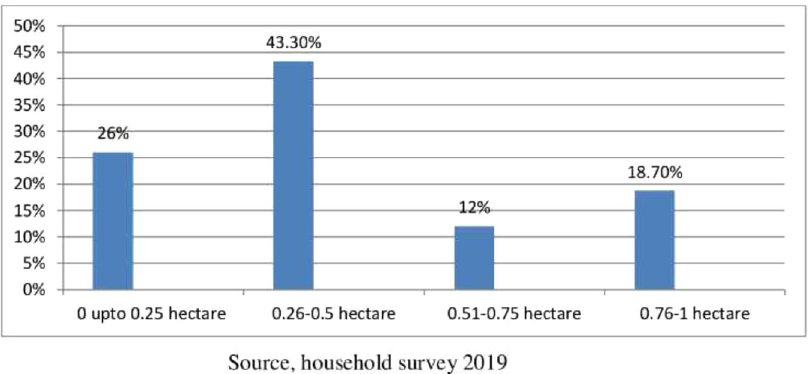
Fig. 2 Surveyed households ’ farmland holding size around Birr and Ayehu farms. Figure basically indicates the land size held by surveyed households in the study area generated from the fi eld survey of study participants. Among the total respondents, about 26, 43.3, 12 and 18.7 percent of respondents held below 0.25, between 0.26 up to 0.5, 0.51 up to 0.75 and above 0.75 ha of land, respectively.